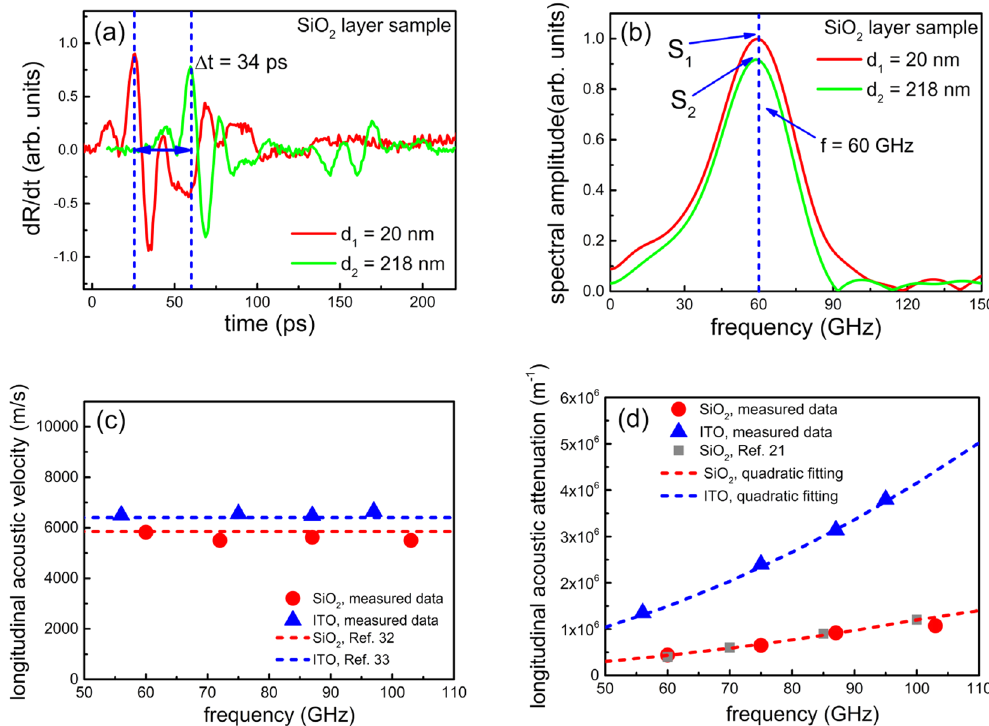
Figure 5. Measurement of frequency-dependent acoustic phonon transport in SiO 2 and ITO films. ( a ) The transient reflectivity signals induced by narrowband acoustic phonons with centre frequency at 60 GHz transmitted through SiO 2 layers of different thicknesses, i.e., 20 nm and 218 nm. ( b ) The Fourier spectrums of the corresponding transmitted acoustic phonon signals at frequency of 60 GHz. ( c ) The longitudinal acoustic phonon velocity of SiO 2 and ITO at various frequencies from 50 to 110 GHz. ( d ) The longitudinal acoustic phonon attenuation coefficients of SiO 2 and ITO at various frequencies from 50 to 110